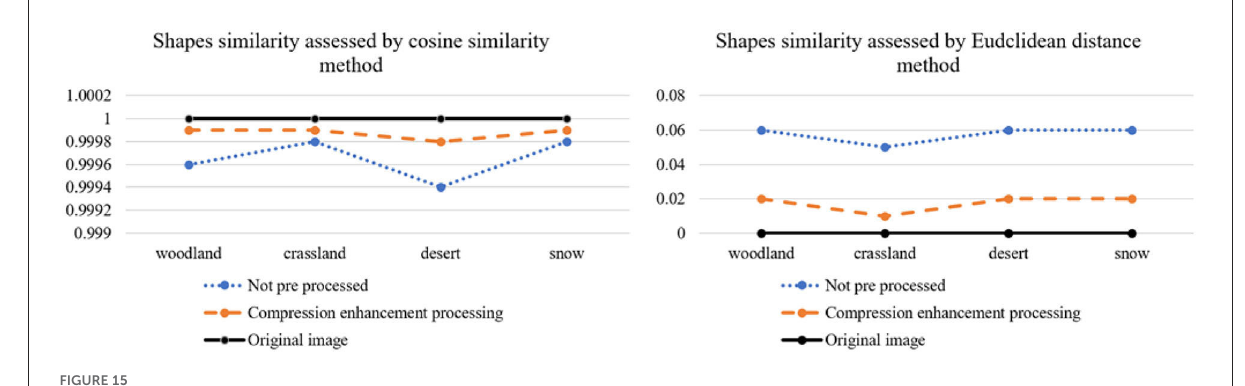
FIGURE15 Shapes similarity assessment